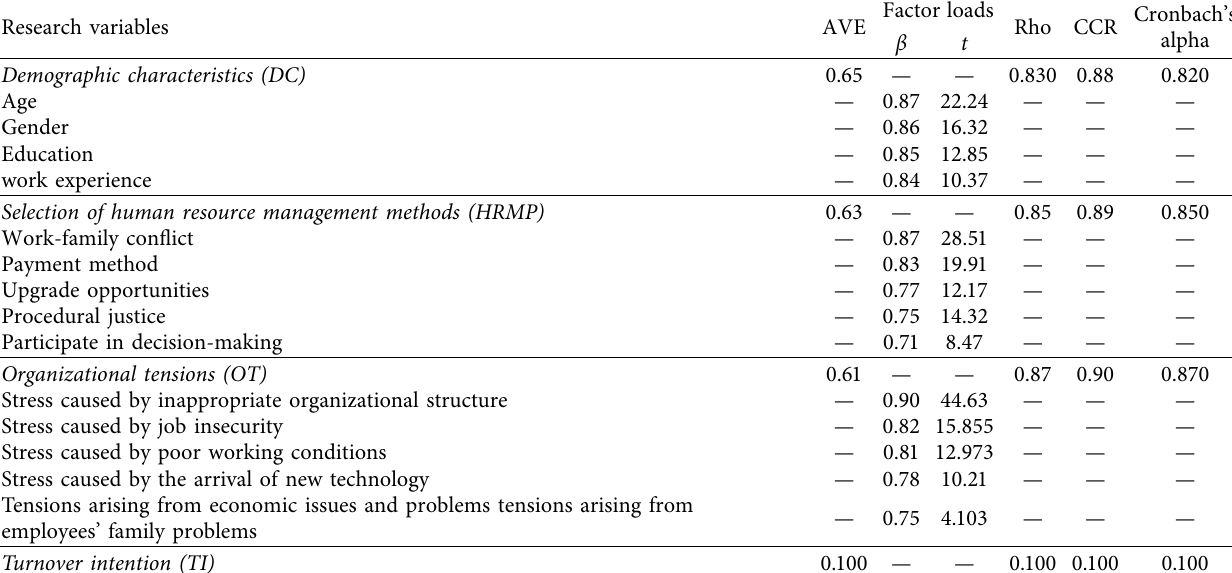
Table 2: Convergent validity and reliability of measurement tools.